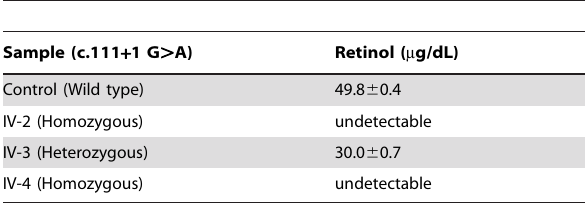
Table 1. Levels of serum retinol in siblings with the RBP4 c.111 + 1 G . A